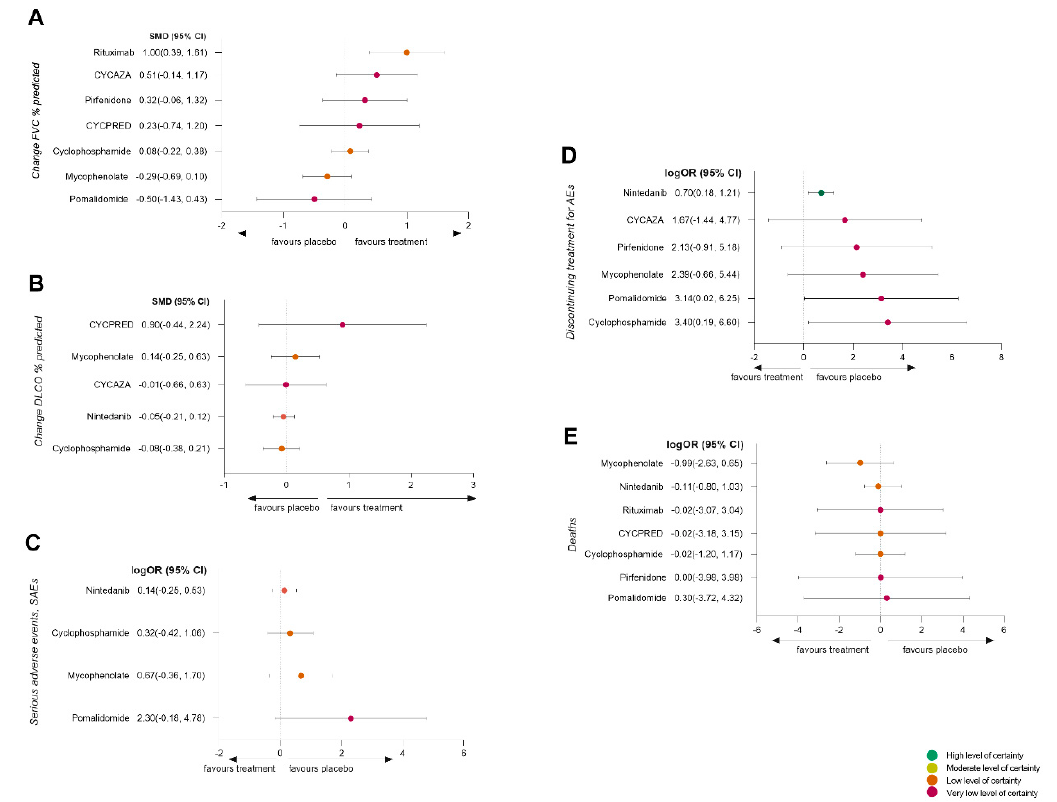
Figure 3. Forest plots. Forest plots of network meta-analysis of all trials: ( A ), change in forced vital capacity % of predicted (FVC %); ( B ), change in diffusion lung capacity for CO % of predicted (DLCO %); ( C ), number of patients with serious adverse events (SAEs); ( D ), number of patients discontinuing treatment for adverse events (AEs); ( E ), deaths. Treatments were compared with the placebo. SMD, standardized mean difference; log OR, odds ratio. CI, confidence interval.